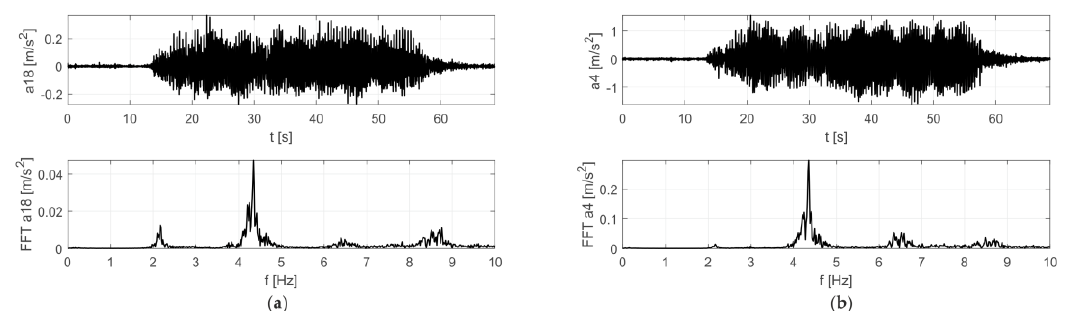
Figure 29. Results of in situ tests after the stand structural tuning from vibration excitation with the jumping supporters: ( a ) girder, ( b ) roof.